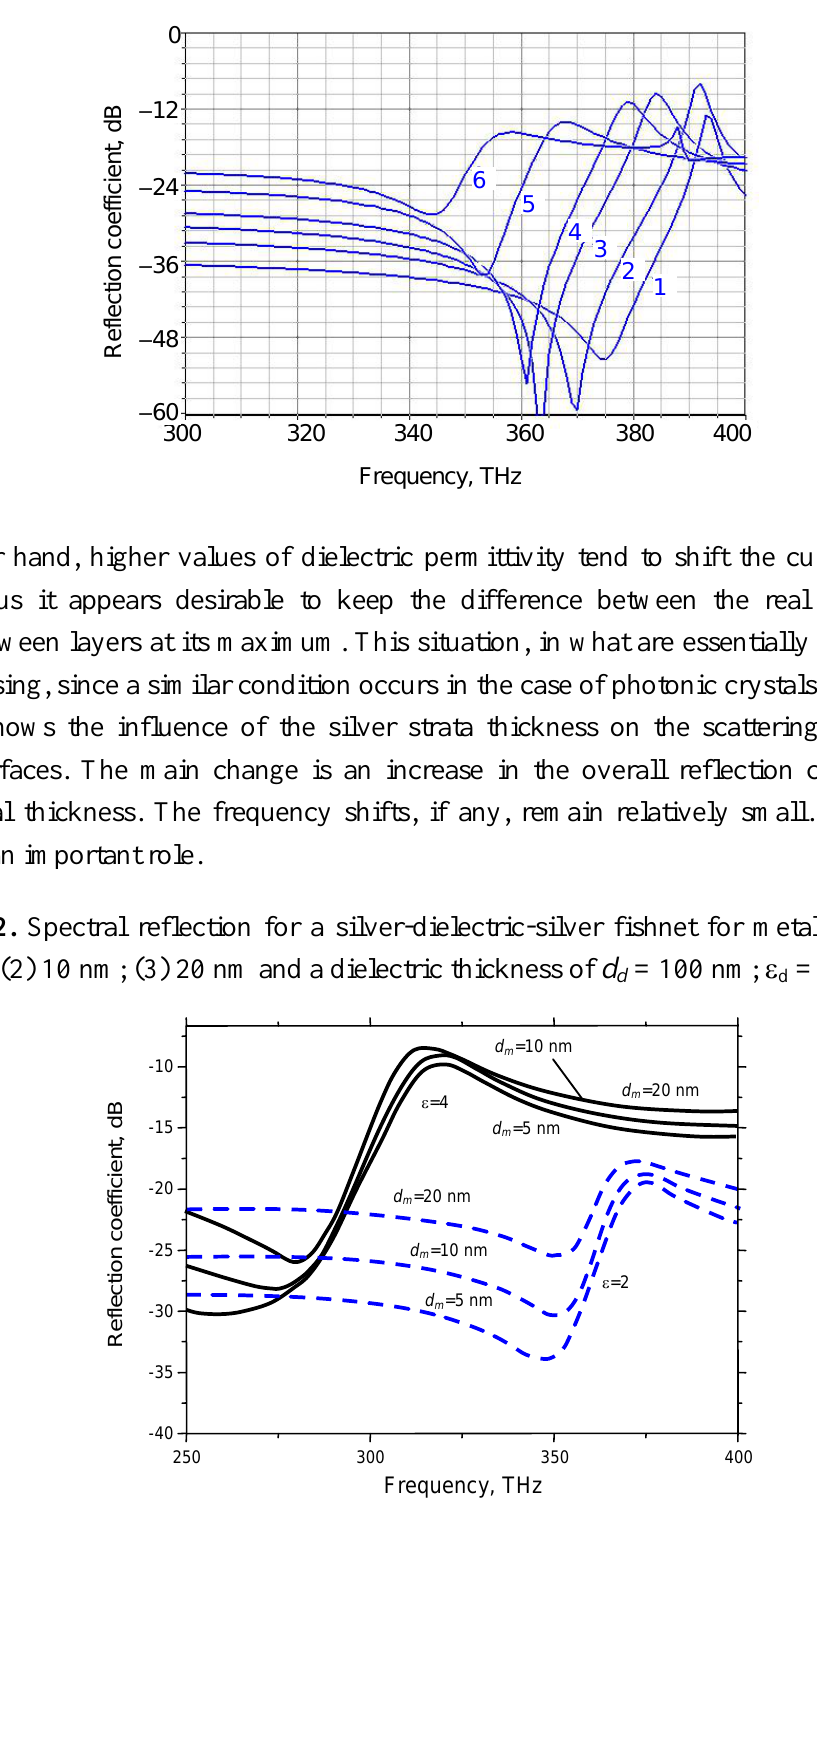
= 5 nm and various m